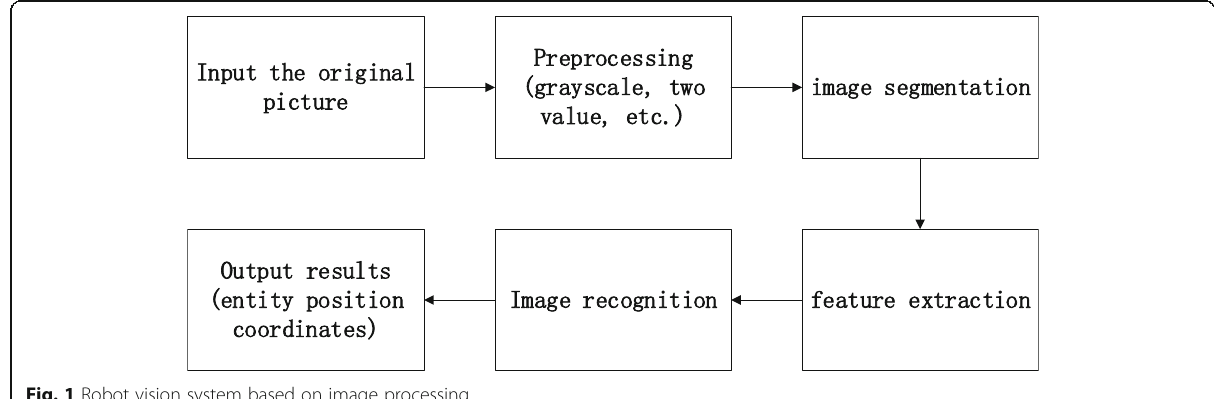
Fig. 1 Robot vision system based on image